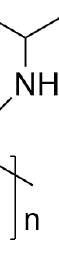
Figure 7. Chemical structure of PNIPAM.